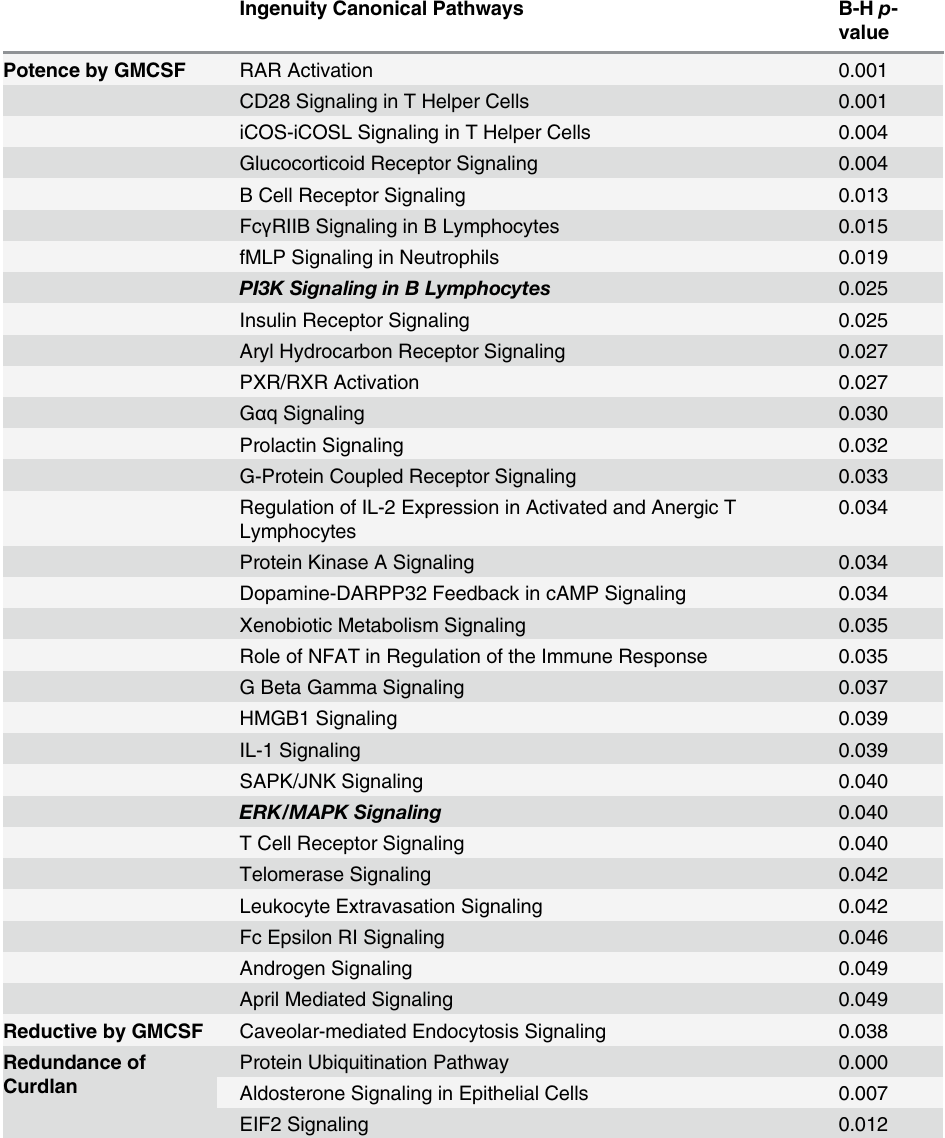
Table 5. Canonical pathways with Benjamini-Hochberg p-value < . 05 for probesets showing potentia- tion or reduction by GM-CSF in the 2×2 experimental setup with 100 μ g